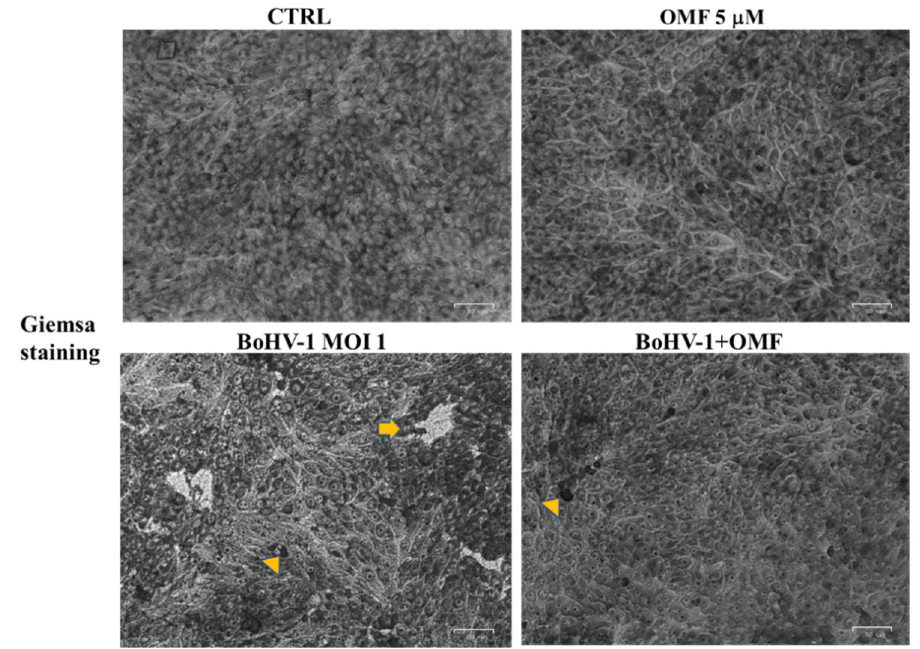
Figure 4. OMF decreases cell membrane damage and morphological cell death features during BoHV-1 infection in MDBK cells. Cells were infected with BoHV-1, in the presence or absence of OMF. At 24 h p.i., cells after Giemsa staining were examined under a light microscope. Photomicrographs showed no morphological alterations in OMF unexposed groups compared to control. By comparing BoHV-1-infected cells to the control, some cells displayed apoptotic features, attributable to pyknotic nuclei and nuclear fragmentation (arrow), or necrosis marks, such as nuclear and cytoplasmic swelling (arrowhead). In OMF-treated infected cells, only a few signs of necrosis were found (arrowhead). Scale bar 50 µm.